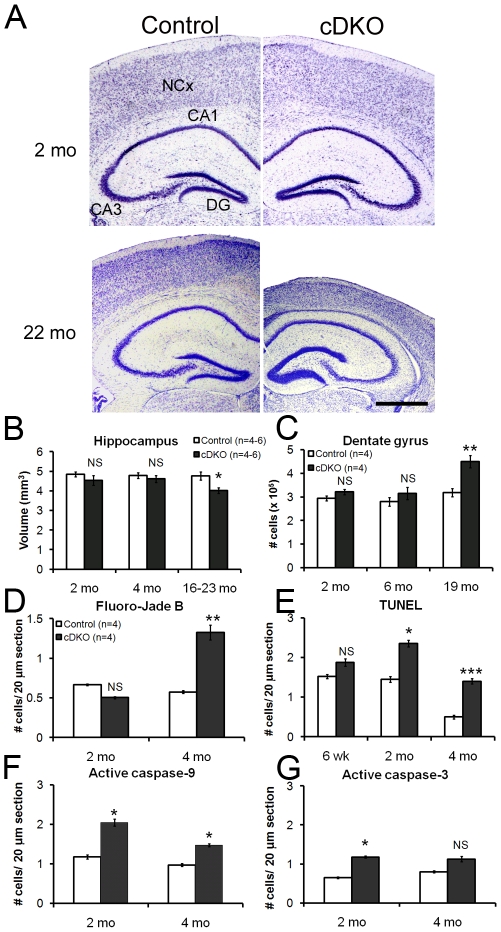
Neurodegeneration and increased adult neurogenesis in the hippocampus of Psen cDKO mice.(A) Images of Nissl-stained brain sections at 2 and 22 months of age. At 2 months, the neocortex (NCx), hippocampal areas CA1 and CA3, and dentate gyrus (DG) are indistinguishable between Psen cDKO and age-matched controls. By 22 months, extensive loss of white and grey matter is evident in the neocortex of Psen cDKO mice. In the hippocampus, loss of white matter in cDKO mice coincides with the increase in neurons in the dentate gyrus. Scale bar: 1 mm. (B) Stereological quantification of hippocampal volumes. The volume of the Psen cDKO hippocampus is normal at 2 months (control: 4.85×105; cDKO: 4.54×105; p>0.05) and 4 months (control: 4.78×105; cDKO: 4.61×105; p>0.05). By 16–23 months, a 15.5% reduction in hippocampal volume is observed (control: 4.76×105; cDKO: 4.02×105; *p<0.05). NS: not significant; n = 4 mice per genotype (2 mo, 4 mo); n = 6 mice per genotype (16–23 mo). (C) Stereological quantification of the number of cells within the hippocampal dentate gyrus (DG). Cell number in the DG is comparable between cDKO and control mice at 2 months (control: 2.94×105; cDKO: 3.21×105; p>0.05) and 6 months (control: 2.80×105; cDKO: 3.15×105; p>0.3). In contrast, by 19 months, Psen cDKO mice have significantly greater numbers of cells in the DG (control: 3.18×105; cDKO: 4.51×105; **p<0.01)(n = 4 mice per genotype per age). (D) Quantification of Fluoro-Jade B+ degenerating neurons. At 2 months, similar numbers of Fluoro-Jade B+ cells are present in control and cDKO mice (p>0.05), in contrast to a 2.3-fold increase in Psen cDKO mice by 4 months of age (*p<0.05)(n = 4 mice per genotype per age; 10 sections analyzed per mouse). (E) Quantification of apoptotic neurons. Increases in TUNEL+ cells are present in the Psen cDKO hippocampus at 2 months (*p<0.05) and 4 months (***p<0.001), whereas the number of TUNEL+ cells is similar in control and cDKO mice at 6 weeks (p> 0.05)(n = 4 mice per genotype per age; 10 sections analyzed per mouse). (F) More active caspase-9+ cells are present in the Psen cDKO hippocampus at 2 months (p<0.05) and 4 months (p<0.05)(n = 4 mice per genotype per age; 10 sections analyzed per mouse). (G) The number of cells positive for active caspase-3+ in the hippocampus is increased in cDKO mice at 2 months (p<0.05), but not significantly increased at 4 months (p>0.05)(n = 4 mice per genotype per age; 10 sections analyzed per mouse). Data are presented as the mean ± s.e.m.